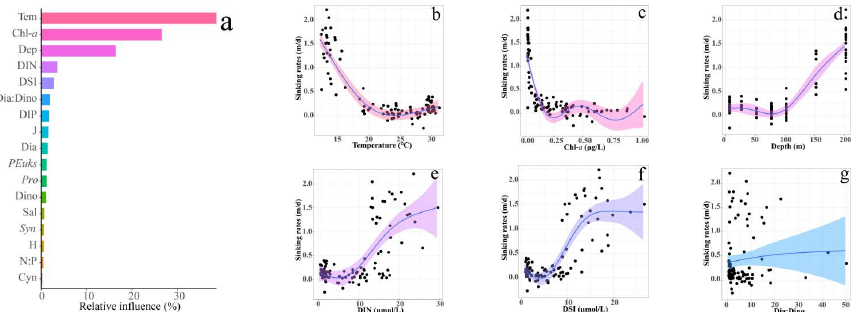
Figure 8. Aggregated boosted tree (ABT) analysis showed the relative effect of sinking rates on Biological factors and chemical factors ( a ) and Results of GAMs describing the sinking rates with temperature ( b ), Chl- a ( c ), Depth ( d ), DIN ( e ), DSI ( f ), Dia: Dino ( g ) in the EIO. Solid bule lines represent smoothed mean relationships from GAMs, and shaded areas are 95% confidence intervals. The black dots represent residual values. The model R 2 value was 0.797.